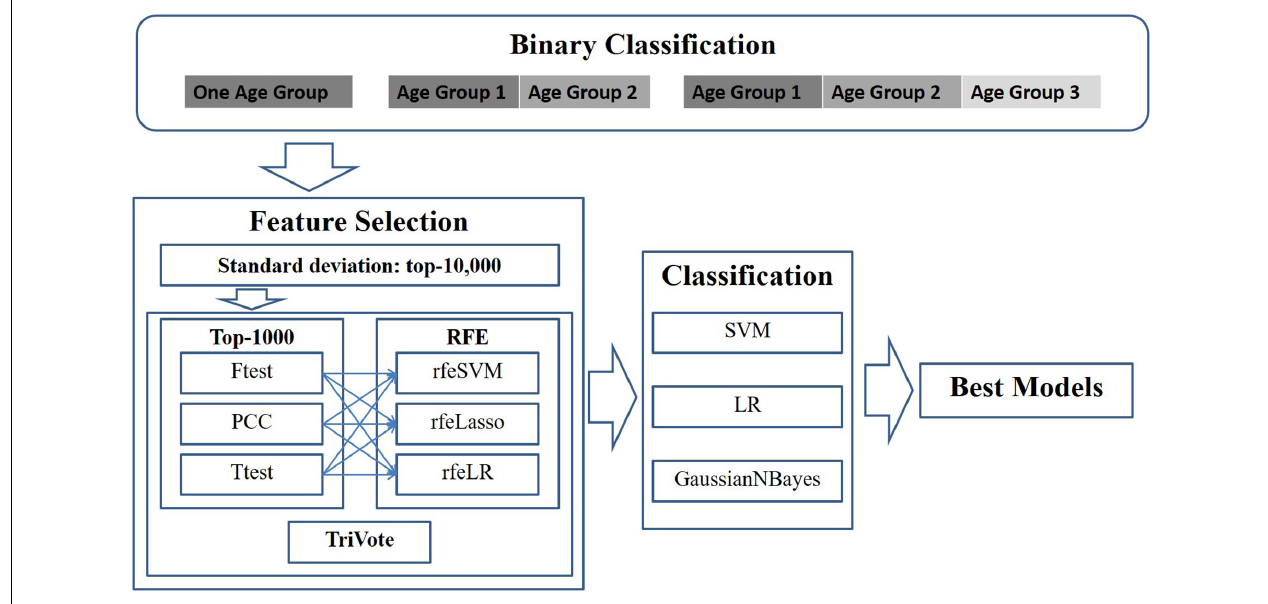
FIGURE 1 | Experimental design of this study. Pairs of three filters and three RFE feature selection algorithms were evaluated for their binary classification performances on the datasets with different age groups. Three binary classifiers were utilized to calculate the classification performances.